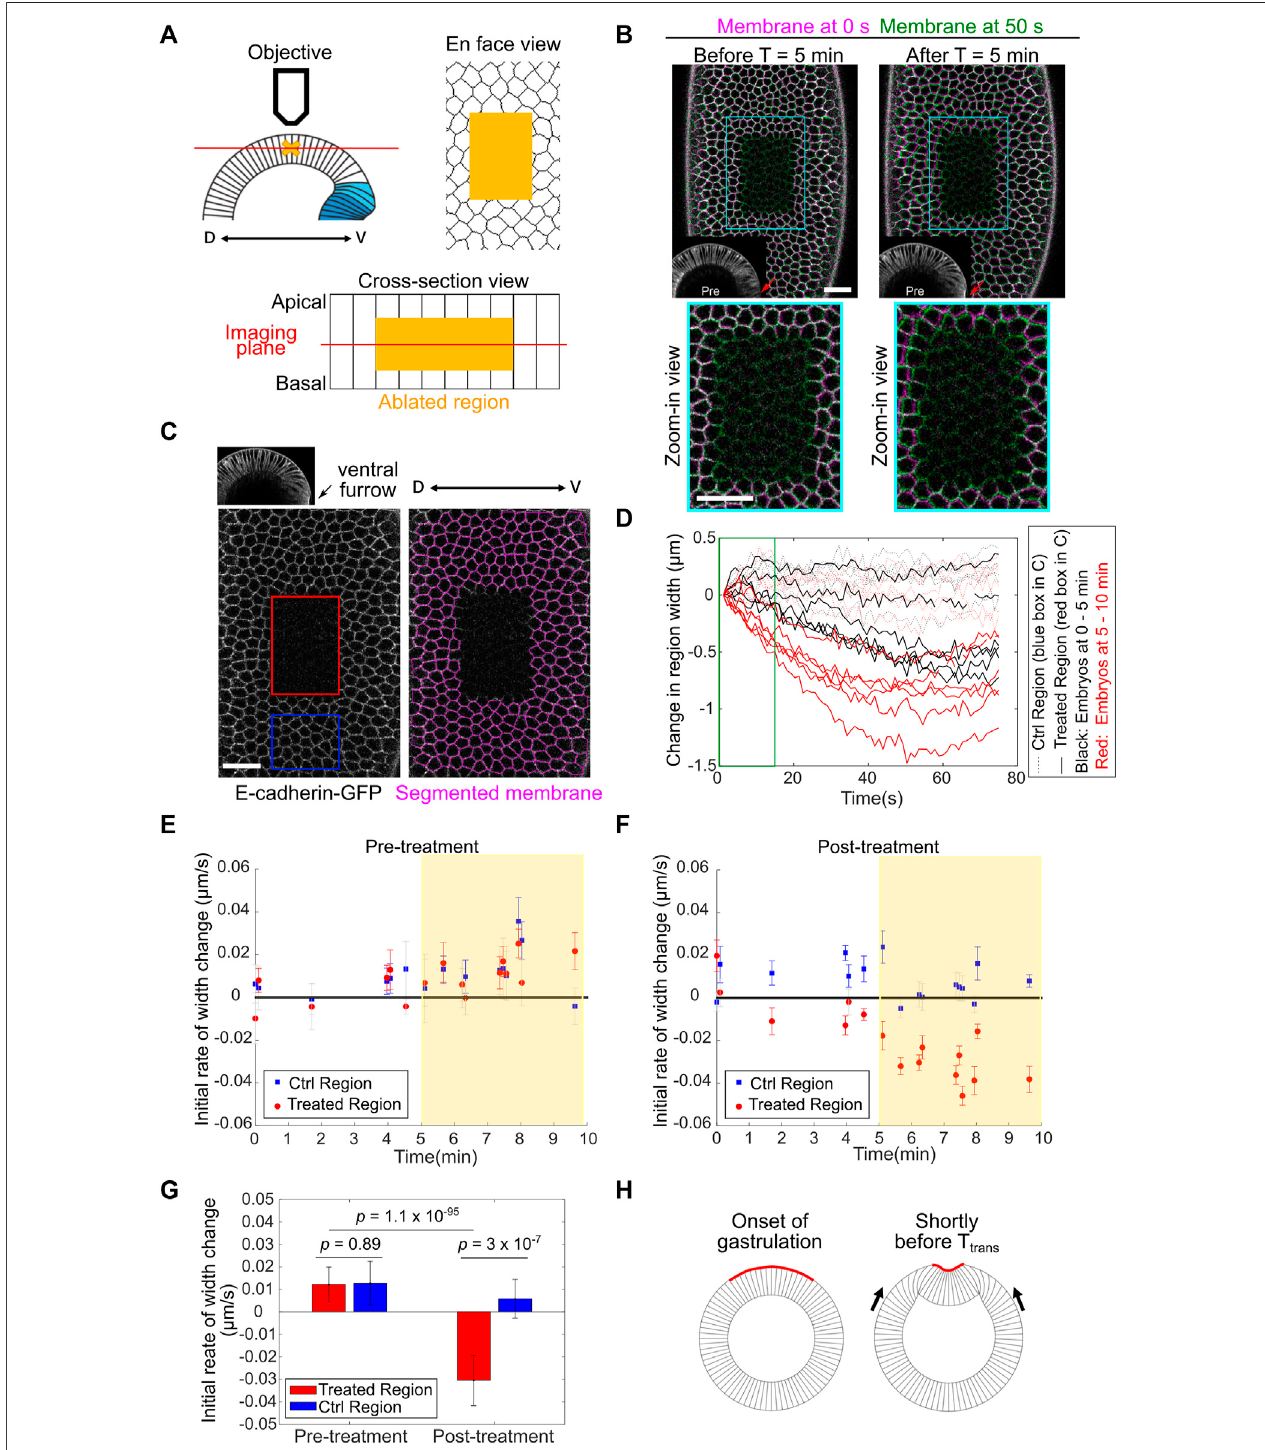
FIGURE 5 | Detection of in-plane compressive stresses in the lateral ectoderm before T trans . (A) Cartoon depicting the experimental setup for laser ablation to detect compressive stresses. The middle region of the ectodermal cells (yellow cross and yellow shades) was ablated using a 920 nm fs laser. Post-ablation tissue movement was recorded by single-plane (red line) fast imaging. (B) Examples showing the immediate response of the tissue after laser ablation carried out during 0 – 5 min (left) or 5 – 10 min (right) of gastrulation (ventral furrow formation). Cell membrane signals immediately after ablation (0 s, magenta) or 50 s (green) after ablation are overlayed. Red arrows: ventral midline. Scale bar: 20 μ m. (C) Left: single plane image acquired immediately after laser cutting. Red: laser-treated region.